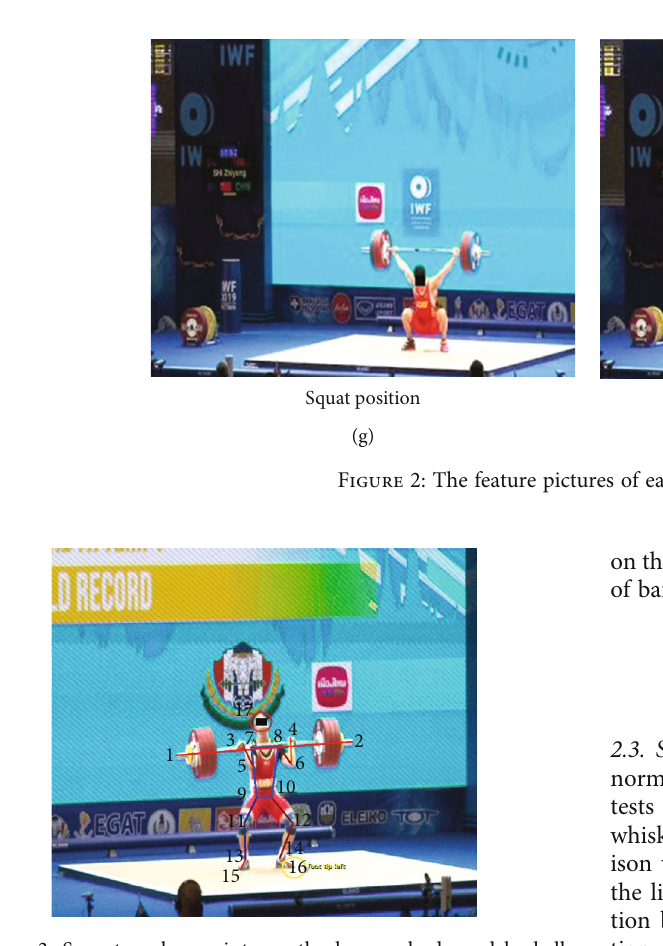
(5) Calculation of Y -Axis Coordinates of Human and Bar Combination Barycenter ( Y ) . The COG of human body c position on the Y - axis is Y 1 , the COG of barbell position on the Y - axis is Y 2 , the weight of lifter is M 1 , and the weight of barbell is M 2 .